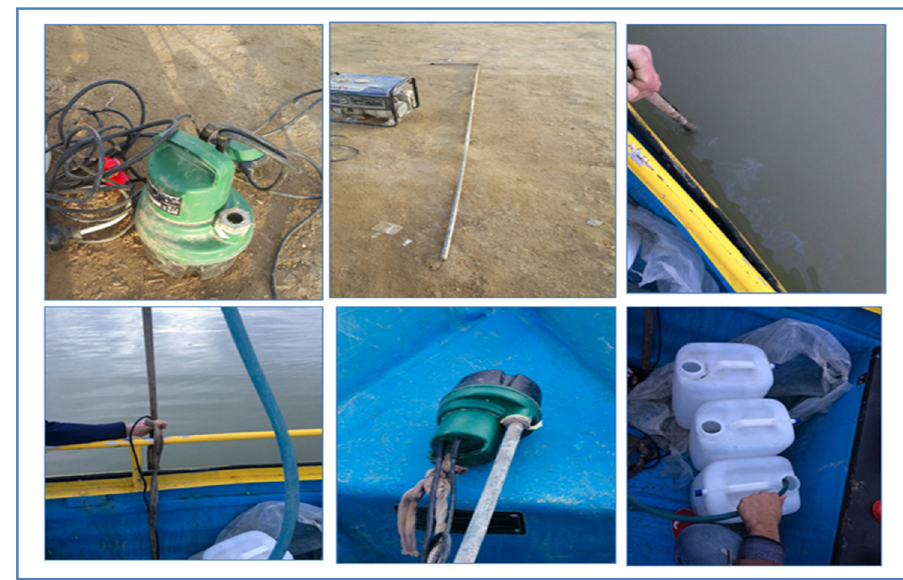
Figure 1: The method of withdrawing samples of water at various